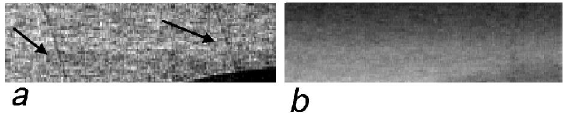
Figure 8. Blow-up region extracted from Figure 7(e) (see rectangle in Figure 7(e)) showing the visibility of the thin aluminum wires in the XPCi images ( a ). The same area was extracted from Figure 7(f) ( b ), showing that in this case the wires are invisible. Note that the border of the disk-shaped object, visible in the bottom right corner, is also enhanced by